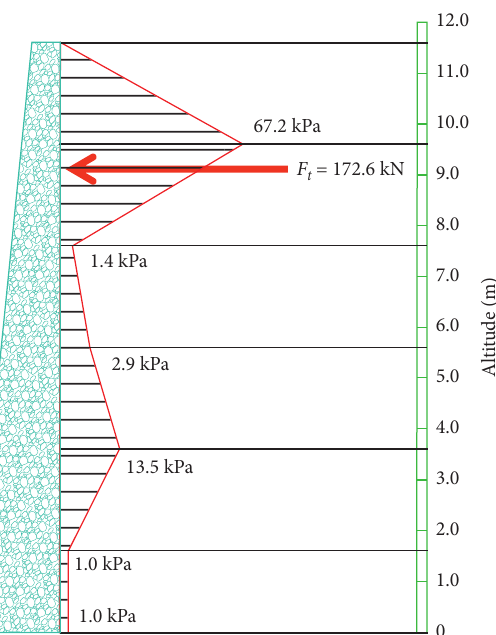
Figure 17: The resultant soil force upon the prototype retaining wall back.